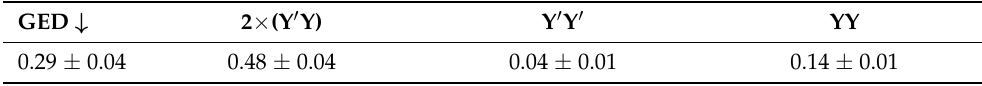
Table 2. GED nodule segmentation performance of the U-HPNet. Each score reports